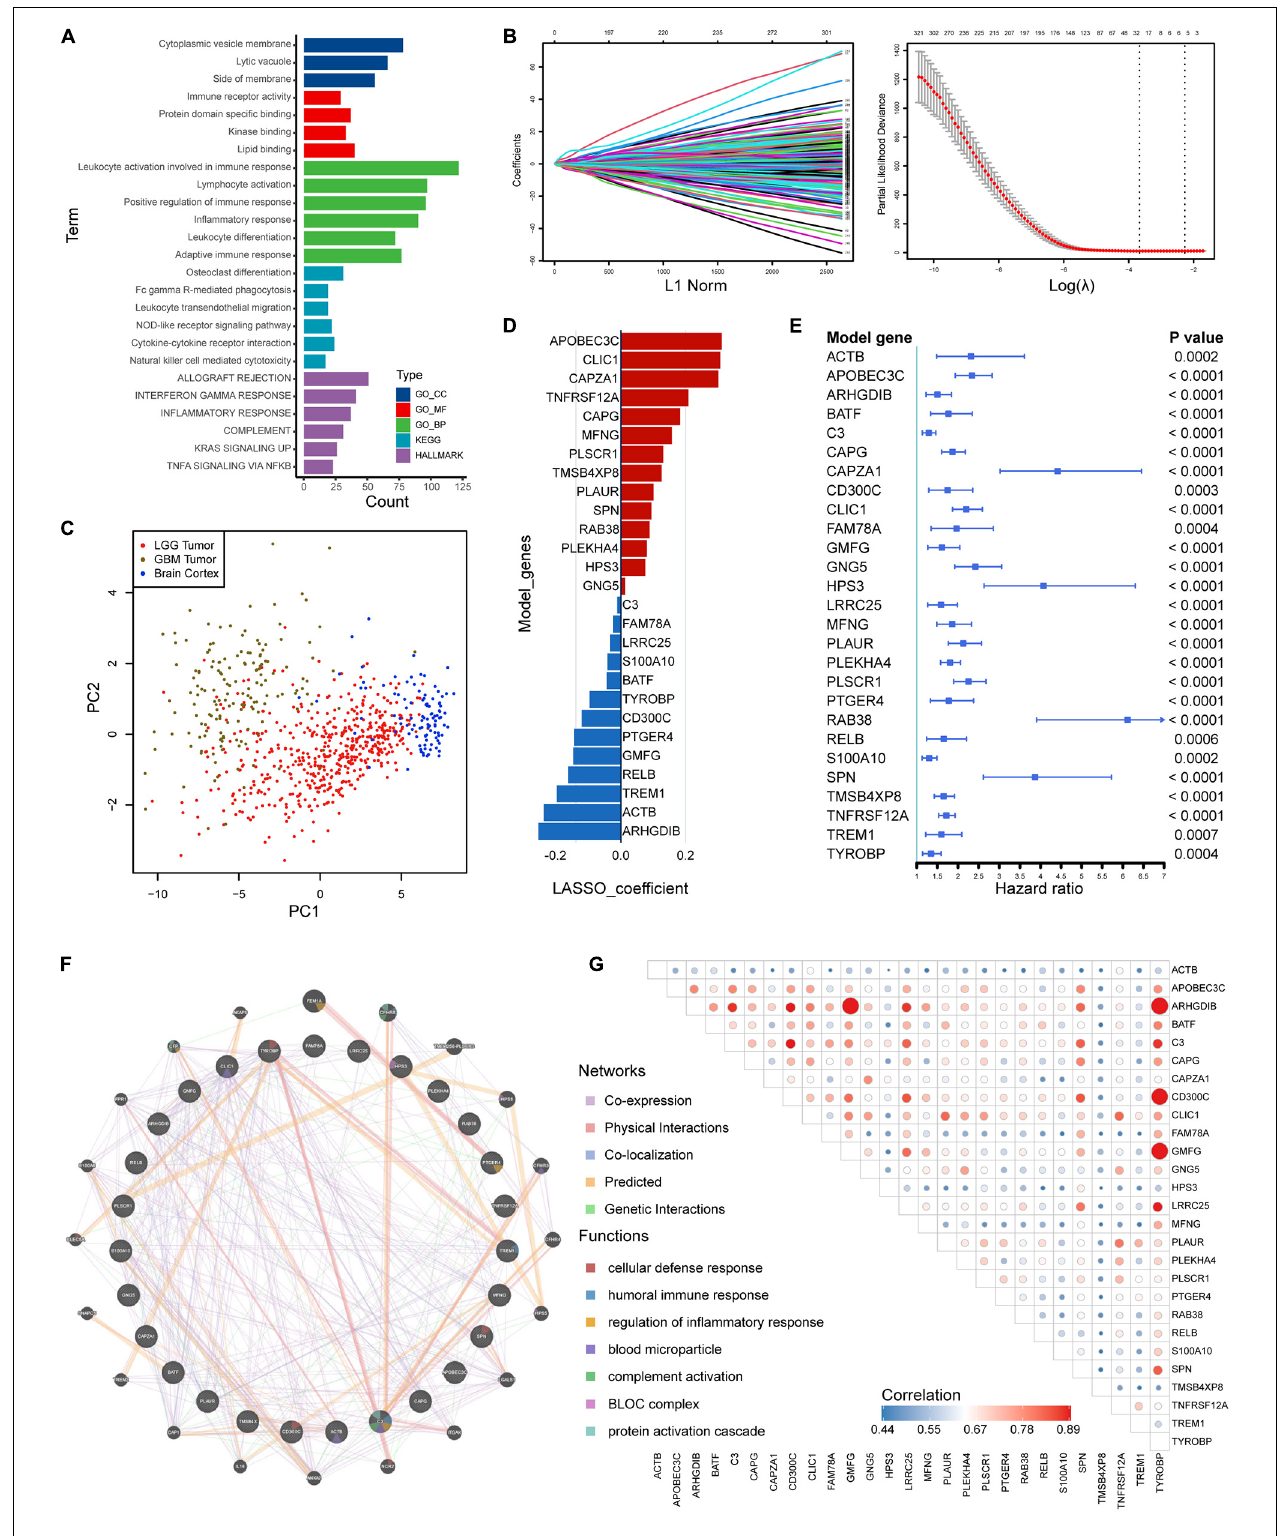
FIGURE 5 | Construction of risk signature based on HRGs in the training set. (A) Enrichment analyses based on HRGs. (B,C) LASSO analysis with eligible lambda value. (C) PCA analysis assessing the signature. (D) LASSO coefficients of the model genes. (E) Univariate analysis results of the model genes. (F) Protein-protein interactions of products of included genes. (G) Correlations among the model genes. GO, Gene Ontology; KEGG, Kyoto Encyclopedia of Genes and Genomes.